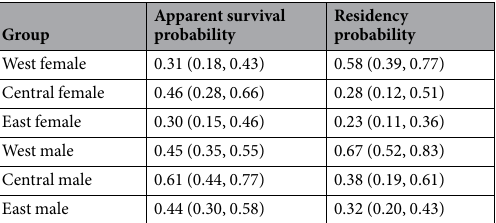
Table 1. Estimated mean apparent adult survival and residency probability of male and female Canada warblers from western, central and eastern regions of the breeding range based on data from the Monitoring Avian Productivity and Survivorship program. Values shown include the mean and 90% credible interval from the posterior